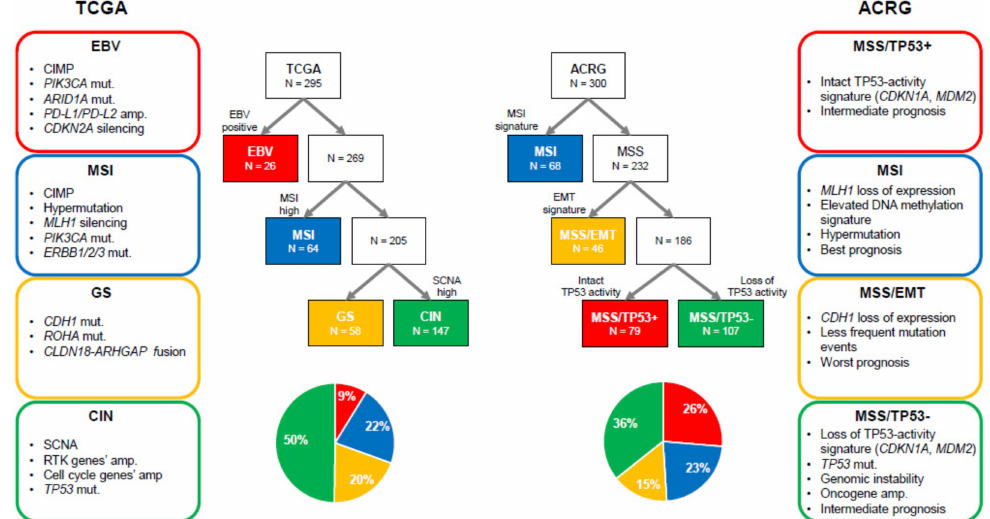
Figure 1. Two di ff erent molecular classifications of gastric cancer. ACRG, Asian Cancer Research Group; amp, amplification; CIMP, CpG island methylation phenotype; CIN, chromosomal instability; EBV, Epstein-Barr virus; EMT, epithelial-mesenchymal transition; GS, genomically stable; MSI, microsatellite instability; MSS, microsatellite stable; mut, mutation; RTK, receptor tyrosine kinase; SCNA, somatic copy number aberrations; TCGA, The Cancer Genome